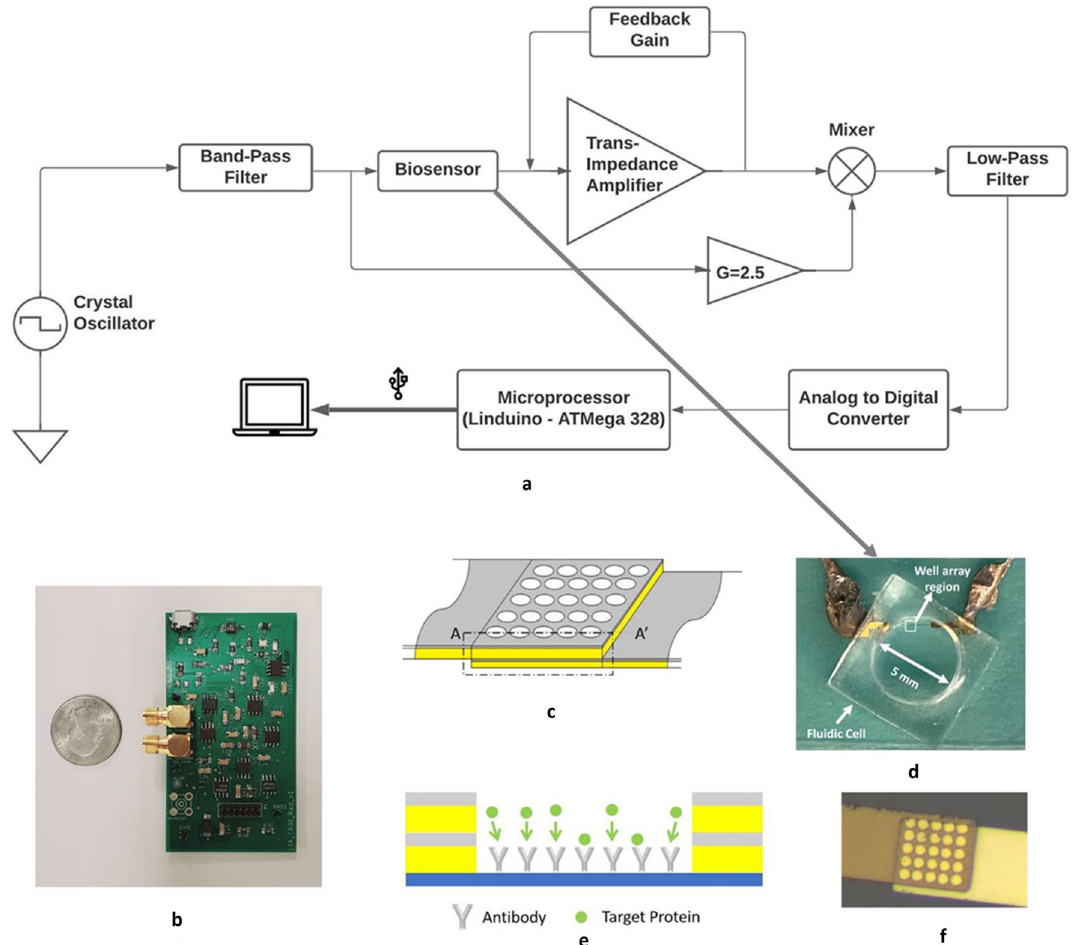
Nanowell Array Impedance Sensor ( d ) Picture of the nanowell array impedance sensor. ( e ) Principle of the nanowell array impedance sensor: the antibodies and target proteins occlude the current path and result in an increase in the impedance ( f ) Microscopic picture of the 5 × 5 nanowell